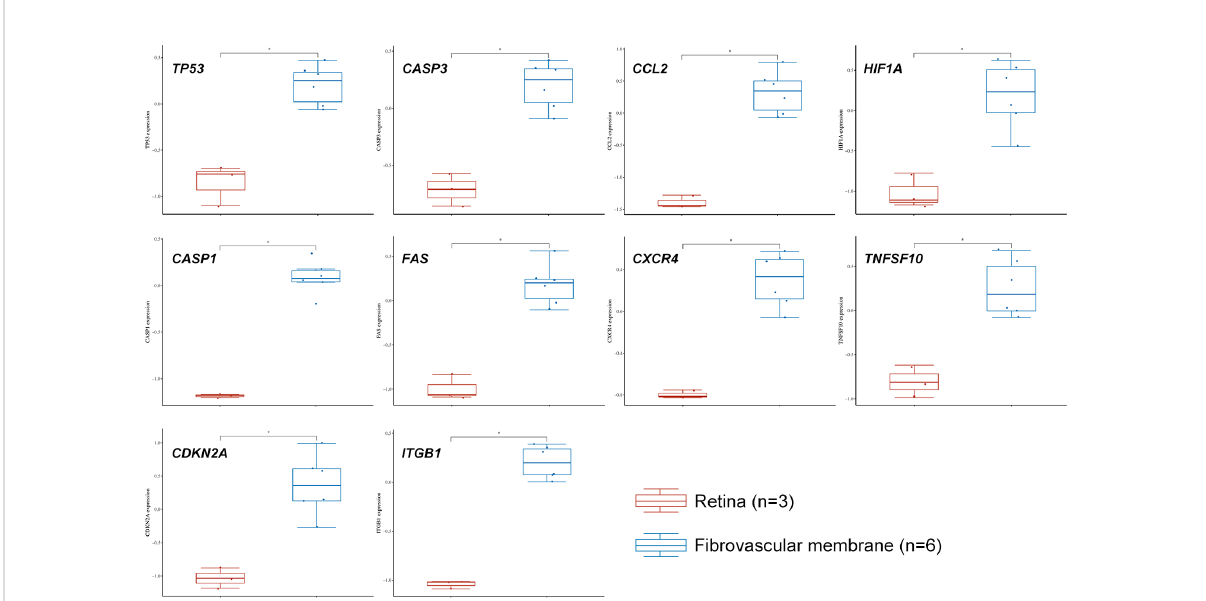
FIGURE 5 The expression distribution of TP53 , CASP3 , CCL2 , HIF1A , CASP1 , FAS , CXCR4 , TNFSF10 , CDKN2A , and ITGB1 in normal retina and fi brovascular membrane. The statistical difference of two groups was compared through the Wilcox test. * P